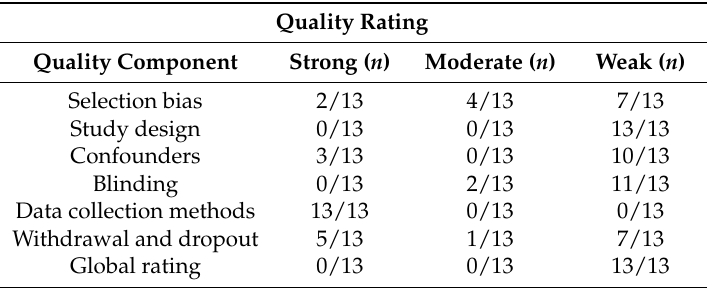
Table 4. Summary of global ratings for study